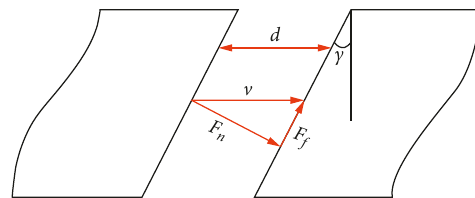
Figure 1: Schematic diagram of structural parameters and inter- action force between